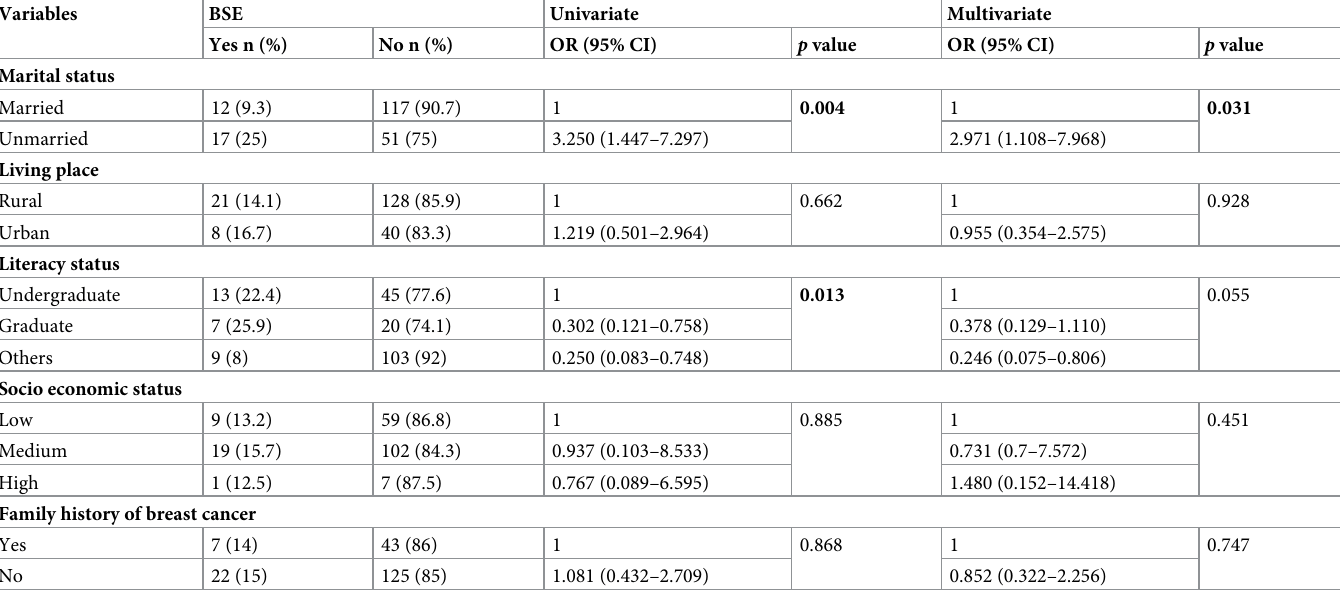
Table 4. Factors associated with performing BSE amongst women who had ever heard of BSE (n =